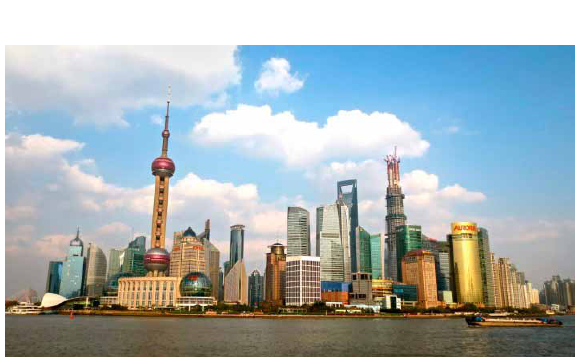
fig. 16. Looper : view of Pudong from the Bund